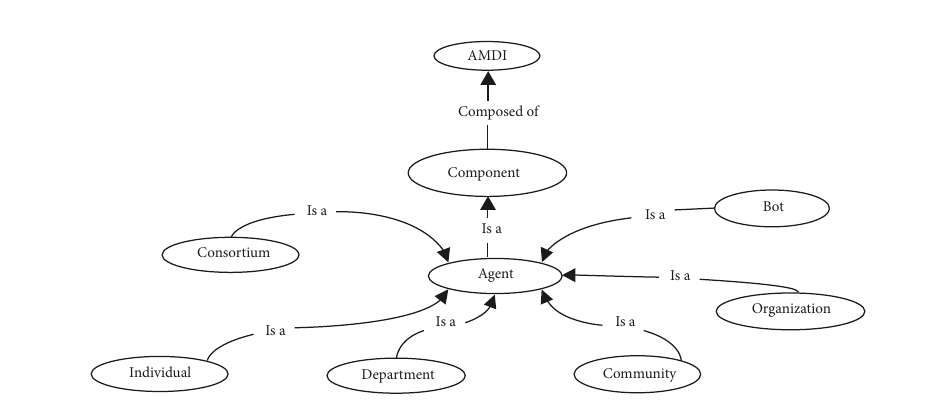
Figure 4: The technology class model.